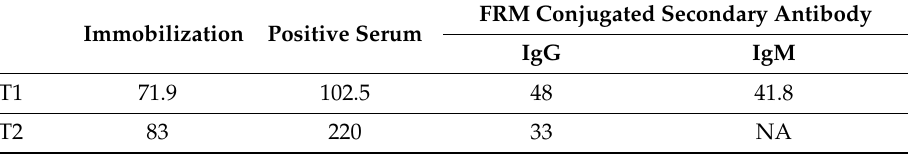
Figure 6. Resonance frequency shifts observed during confirmation experiments for ( a ) TBT1 and ( b ) TBT2. ∆ f versus time of anti − human immunoglobulin G (anti − human IgG) and FRMs conju- gated anti − human immunoglobulin M (anti − human IgM) detections for antibody-positive serum (Ab PS) − treated and negative/control serum (CS) − treated TBT1 are shown in a. ∆ f of FRMs conju- gated anti − human IgG detection for Ab PS − treated and CS − treated TBT2 are shown in ( b ). Table 1. Resonance frequency shifts (Hz) of TBT1 and TBT2 immobilizations, positive serum antibody detections and anti ‐ human IgG and anti ‐ human IgM conjugated FRM confirmations.